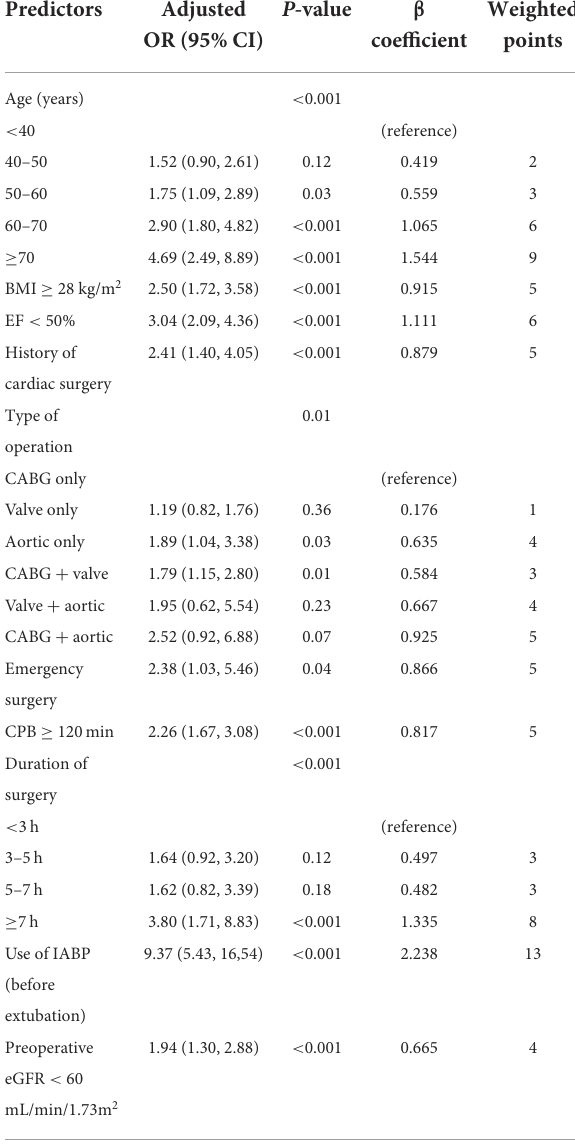
TABLE 2 Multivariable logistic regression model for predictors of delayed extubation and weighted score